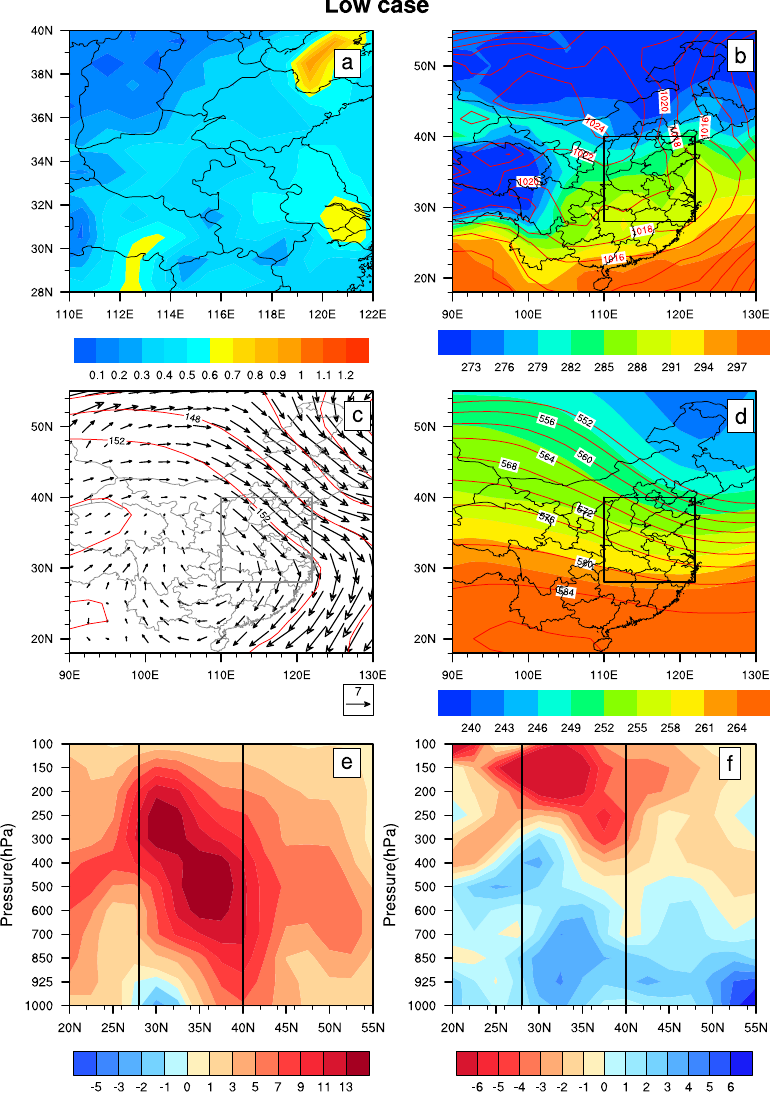
Figure 6. As in Fig. 5 but for the clean episode (21–24 October